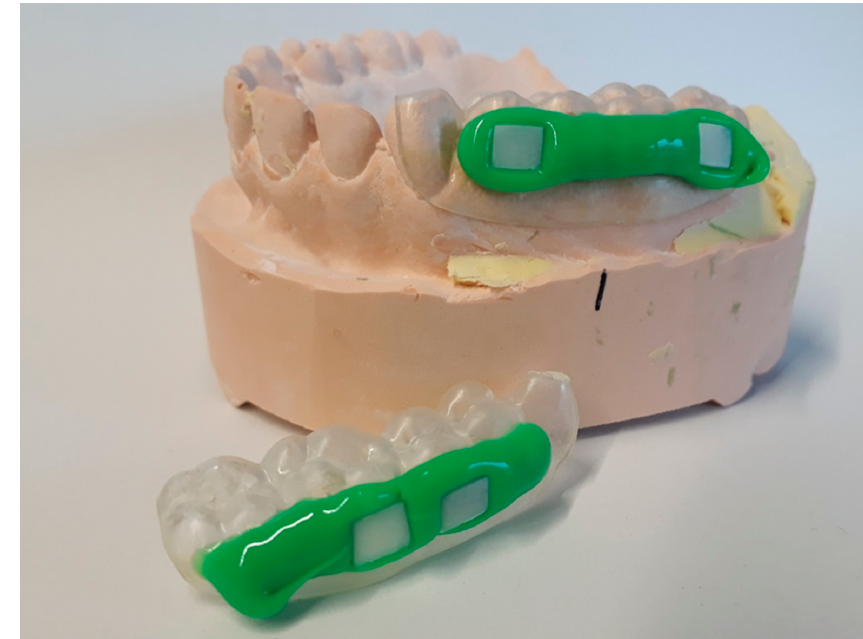
Figure 1. Specimens fixed to splints. Four specimens were fixed with silicone impression material to individual upper jaw splints. After the two-day trial, specimens were examined with fluorescence and scanning electron microscope, each with two specimens. Table 1. Test substances used as mouthwashes in the present